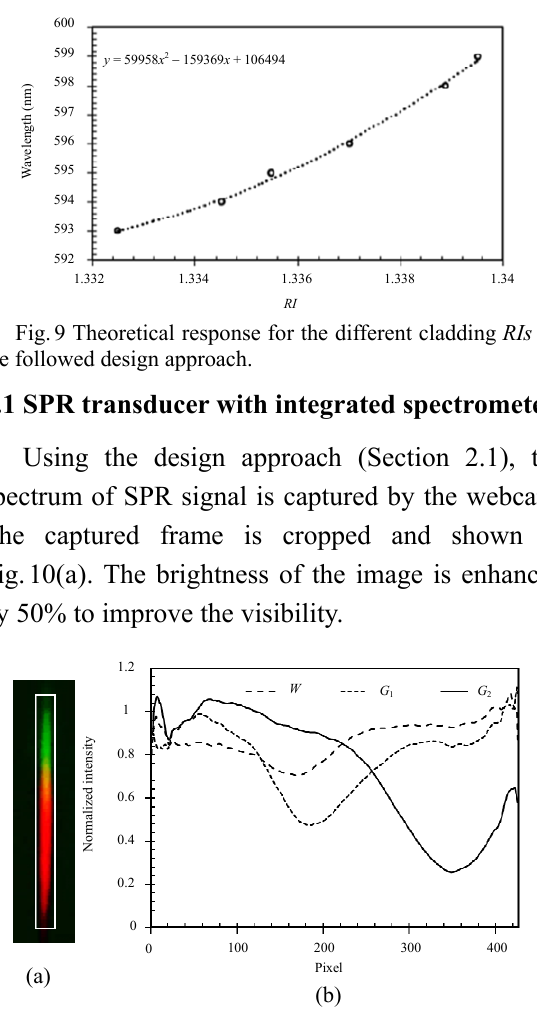
Fig. 10 Spectrum captured by the developed system: (a) the cropped image acquired by the webcam of a spectrum covering green and red color, and also marked with region of interest for image processing and (b) intensity variation for water ( W = 1.33250) and glycerol solution ( G 1 = 1.33547 and G 2 =